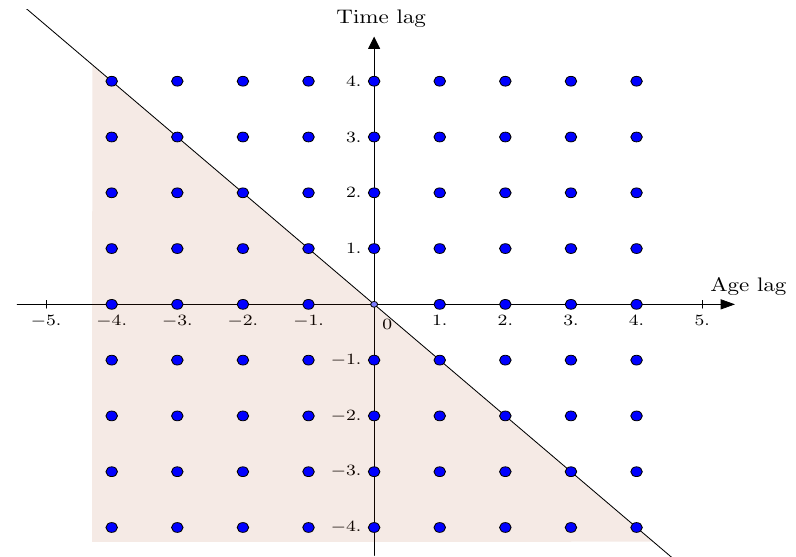
Figure 1. Causal random field: A bi-dimensional representation of the random field X s = IR s − IR with s = ( a , t ) . The grayed area represents the causal neighbor V needed to characterize the evolution of X s